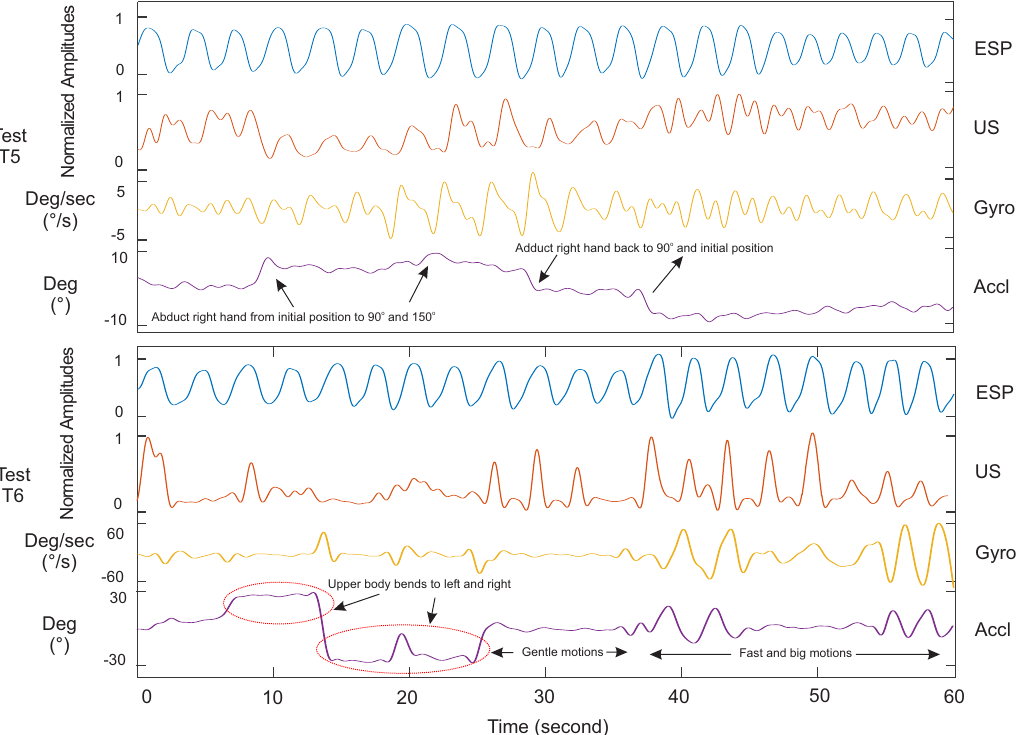
Figure 6. Respiratory waveforms of Subject 4 for the proposed ultrasound system (US) in comparison with the spirometer (ESP) and motion sensor (Accl/Gyro) under human body motion condition. Since the PPG data were found to be sensitive to the motions, data collection was skipped for analysis in T5 and